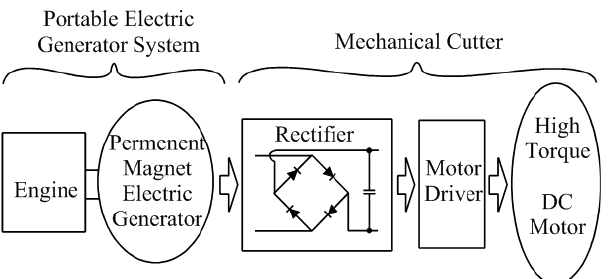
Figure 1. Configuration of a portable harvesting system.